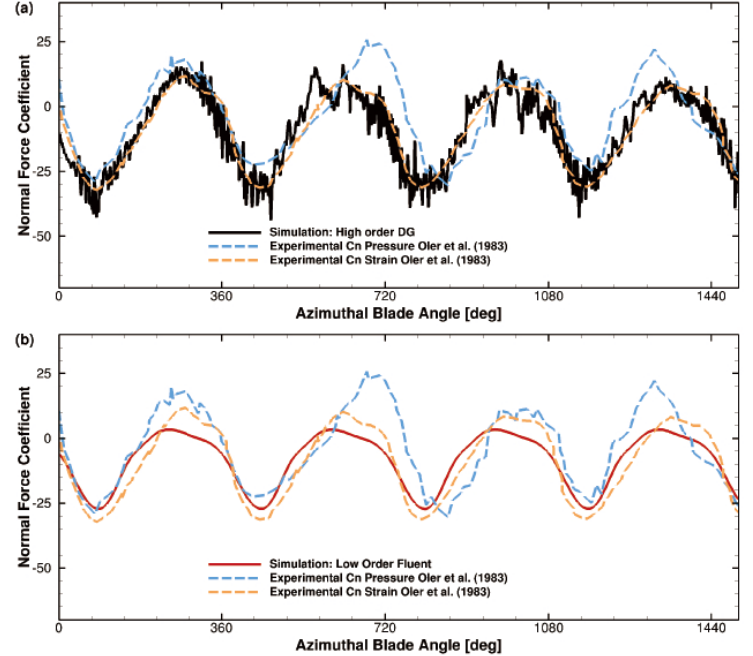
Figure 2. Normal force coefficient for a vertical axis turbine: ( a ) 3D high order DG simulation (LES turbulence model); ( b ) low order fluent simulation (k-omega SST turbulence model. Both compared to experimental data [39] for four turbine